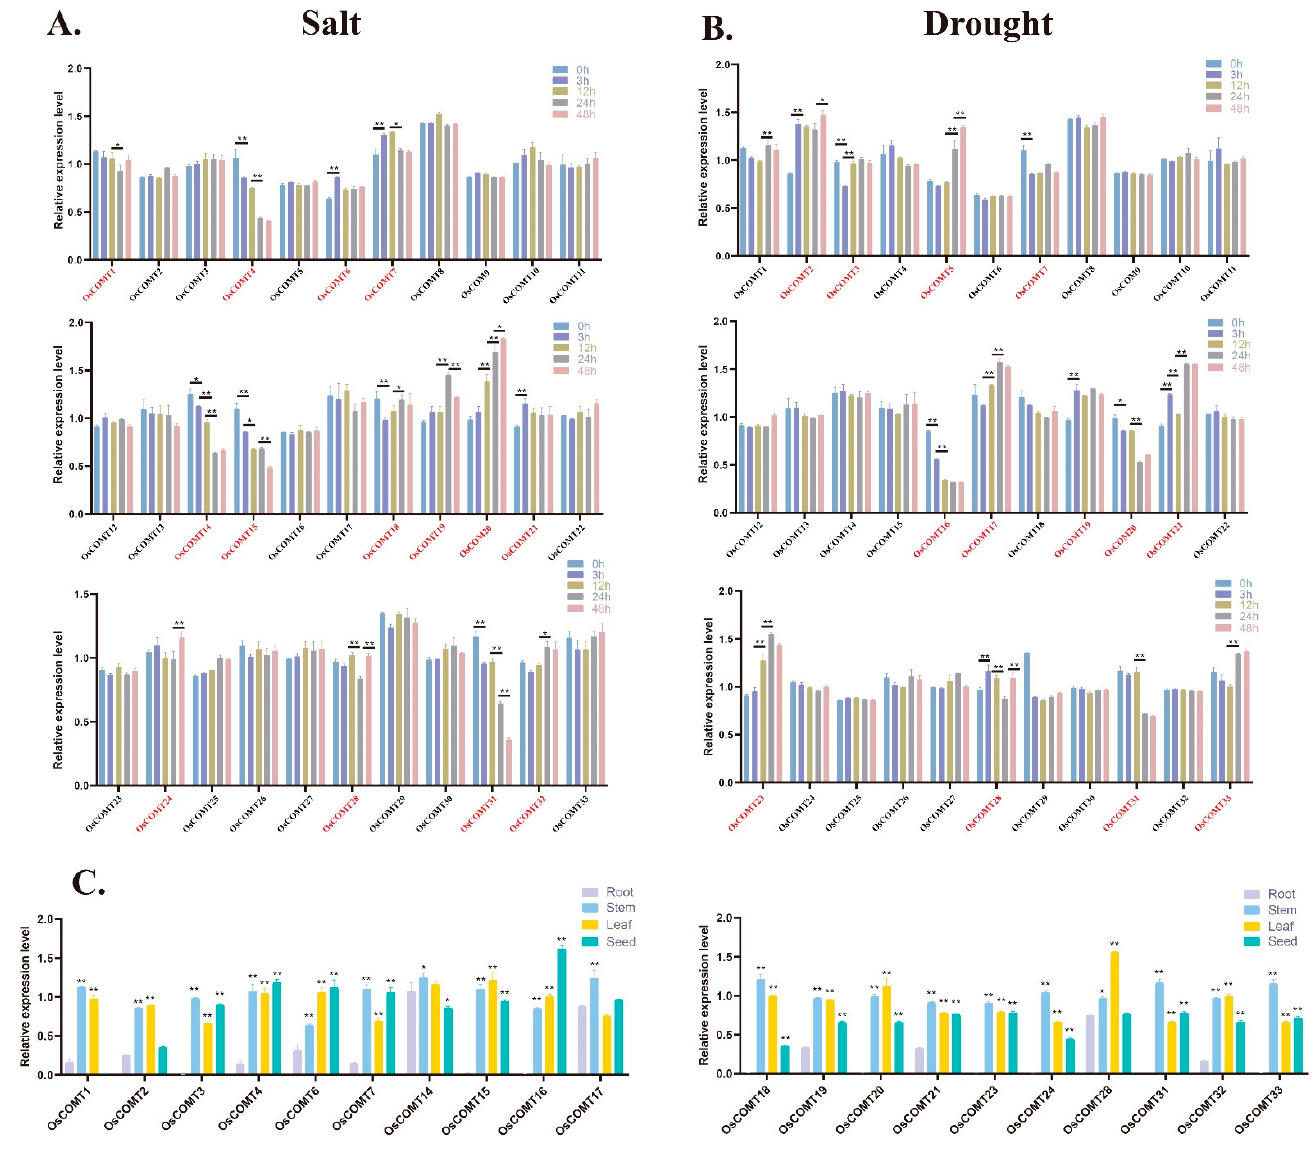
Figure 6. ( A ) Expression levels of differentially expressed OsCOMTs under salt stress. ( B ) Expression levels of differentially expressed OsCOMTs under drought stress. ( C ) Expression of OsCOMTs in seeds, stems, leaves, and roots. Induced OsCOMTs are marked in red. Asterisks indicate that the expression of OsCOMTs was significantly increased or decreased at different times after treatment.